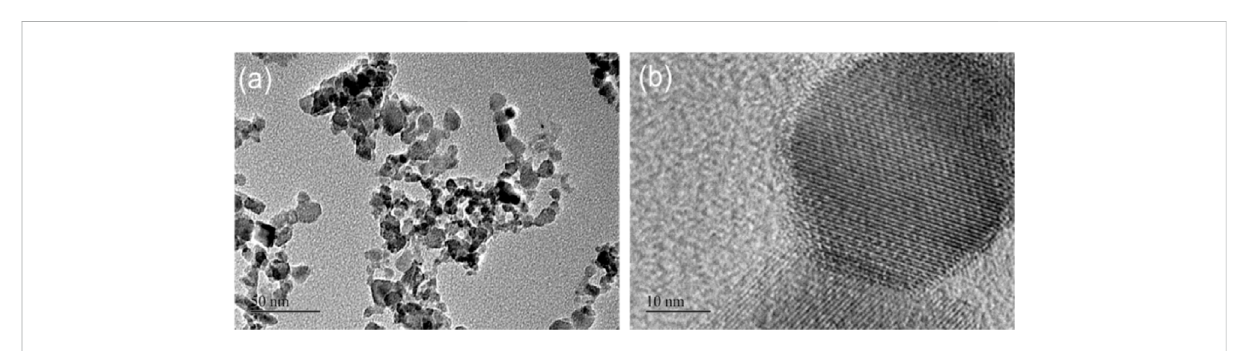
FIGURE 4 TEM images. (A) TEM image, (B) High-revolution TEM image.